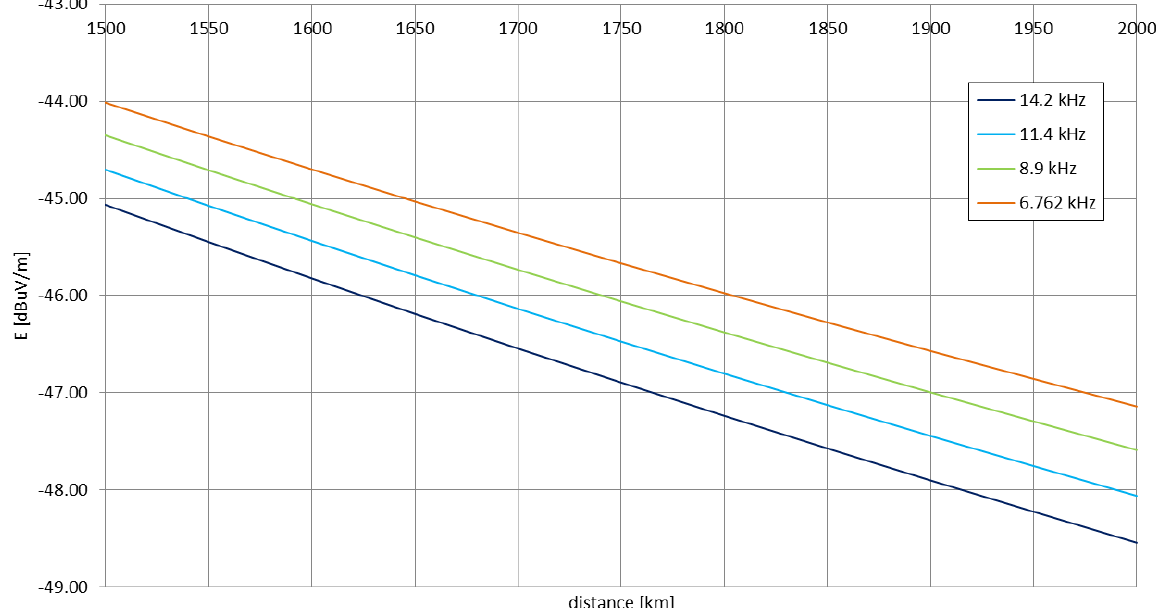
Figure 15. The propagation curves of the considered VLF signal from the altitude-gaining emitter, calculated using the Austin-Cohen formula [52] for the larger distances and radiated power of 1 µ W. The general tendency of the E rising with the decrease of the frequency (the increase of the emitter’s altitude) can be noticed, yet with no characteristic oscillations typical for the VLF propagation. For shorter distances, the curves tend to converge to a single curve. For the LMP simulation, such convergence starts to manifest itself below the distances of 200 km only).